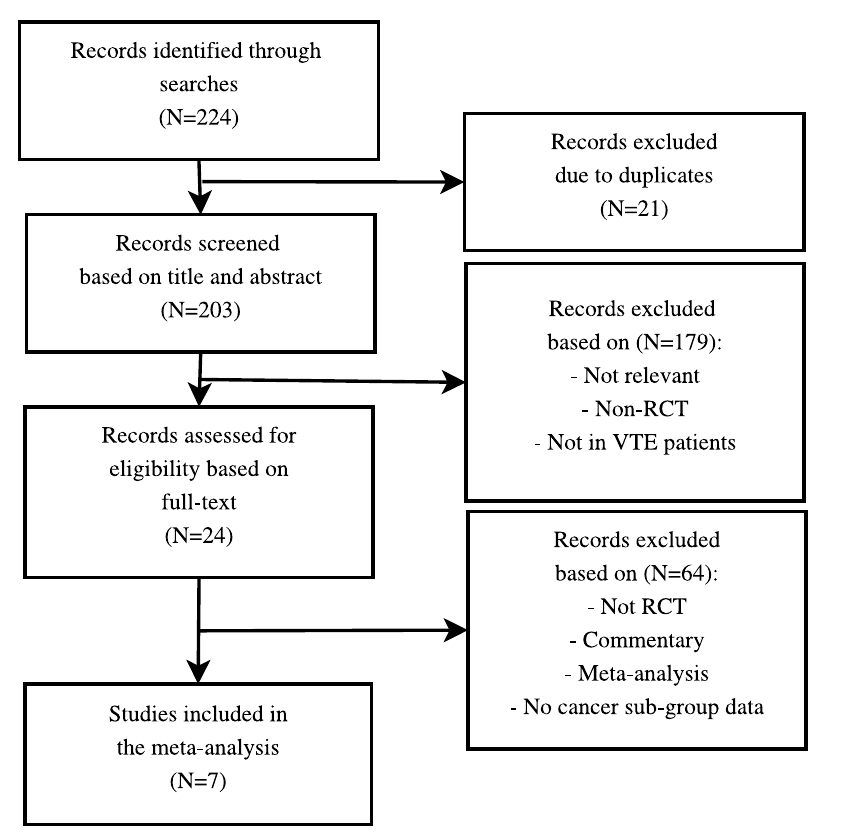
Figure 1. Flowchart of the study selection process. RCT: Randomised controlled trial. VTE: Venous thromboembolism. PE: pulmonary embolism.